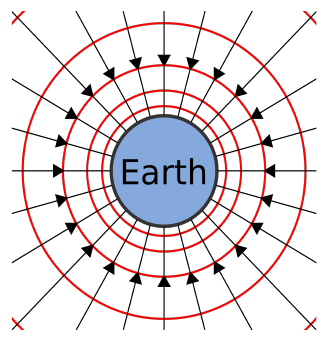
Figure 9. Gravitational field of